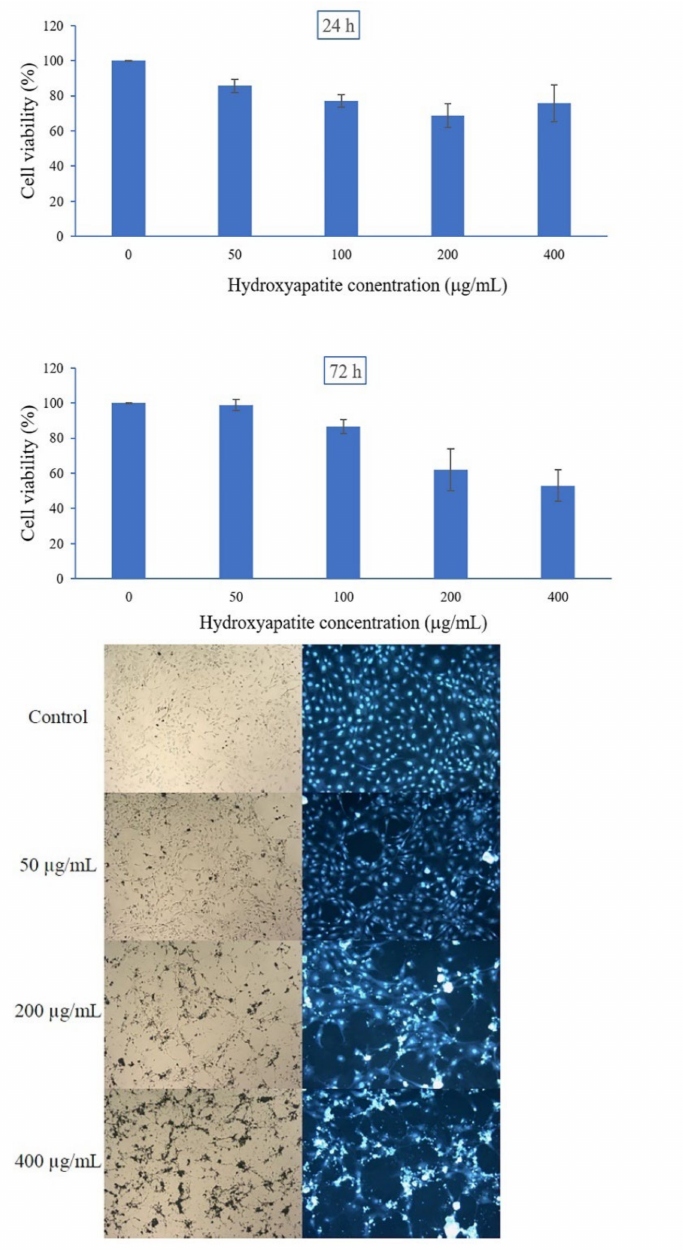
Figure 6. The effects of obtained hydroxyapatite from bigeye snapper bone on MC3T3-E1 cell viability after incubation for 24 and 72 h and cell morphology after incubation for 72 h using optical microscopy and Hoechst stain at 100 × original